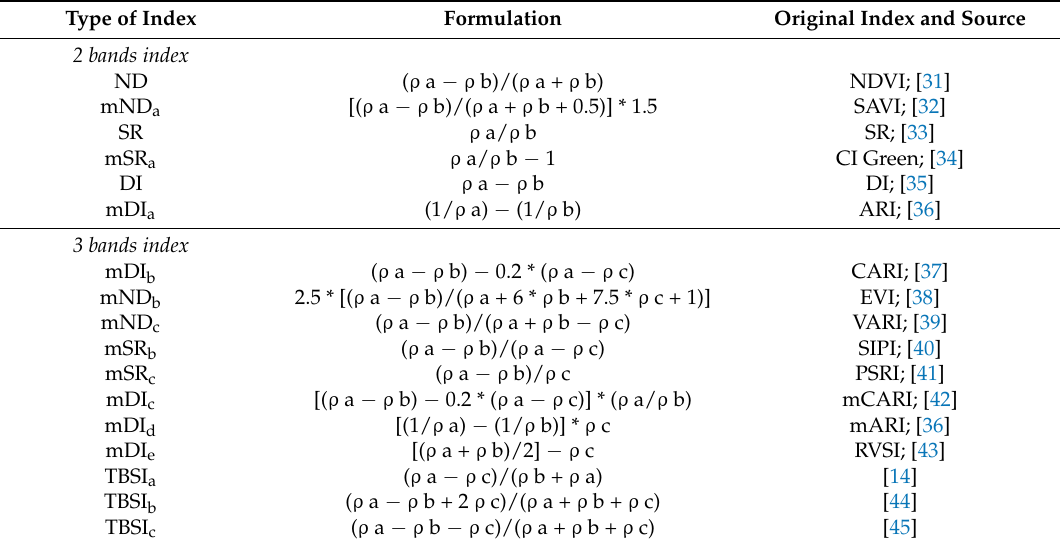
Table 3. Spectral vegetation indices tested for statistical LAI modelling.